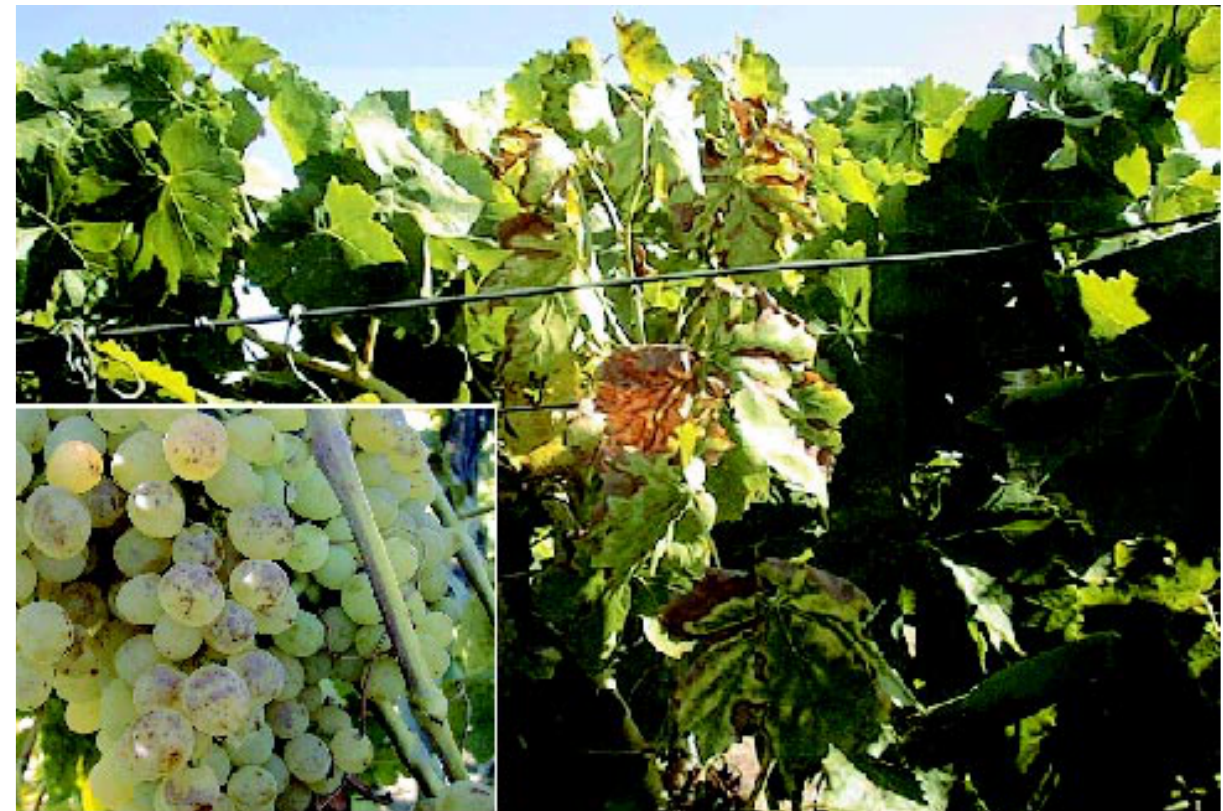
Fig. 1. Symptoms of esca on leaves and fruits of grape cv. Thompson Seedless 3 years after inoculation of pruning wounds with Phaeoacremonium aleophilum